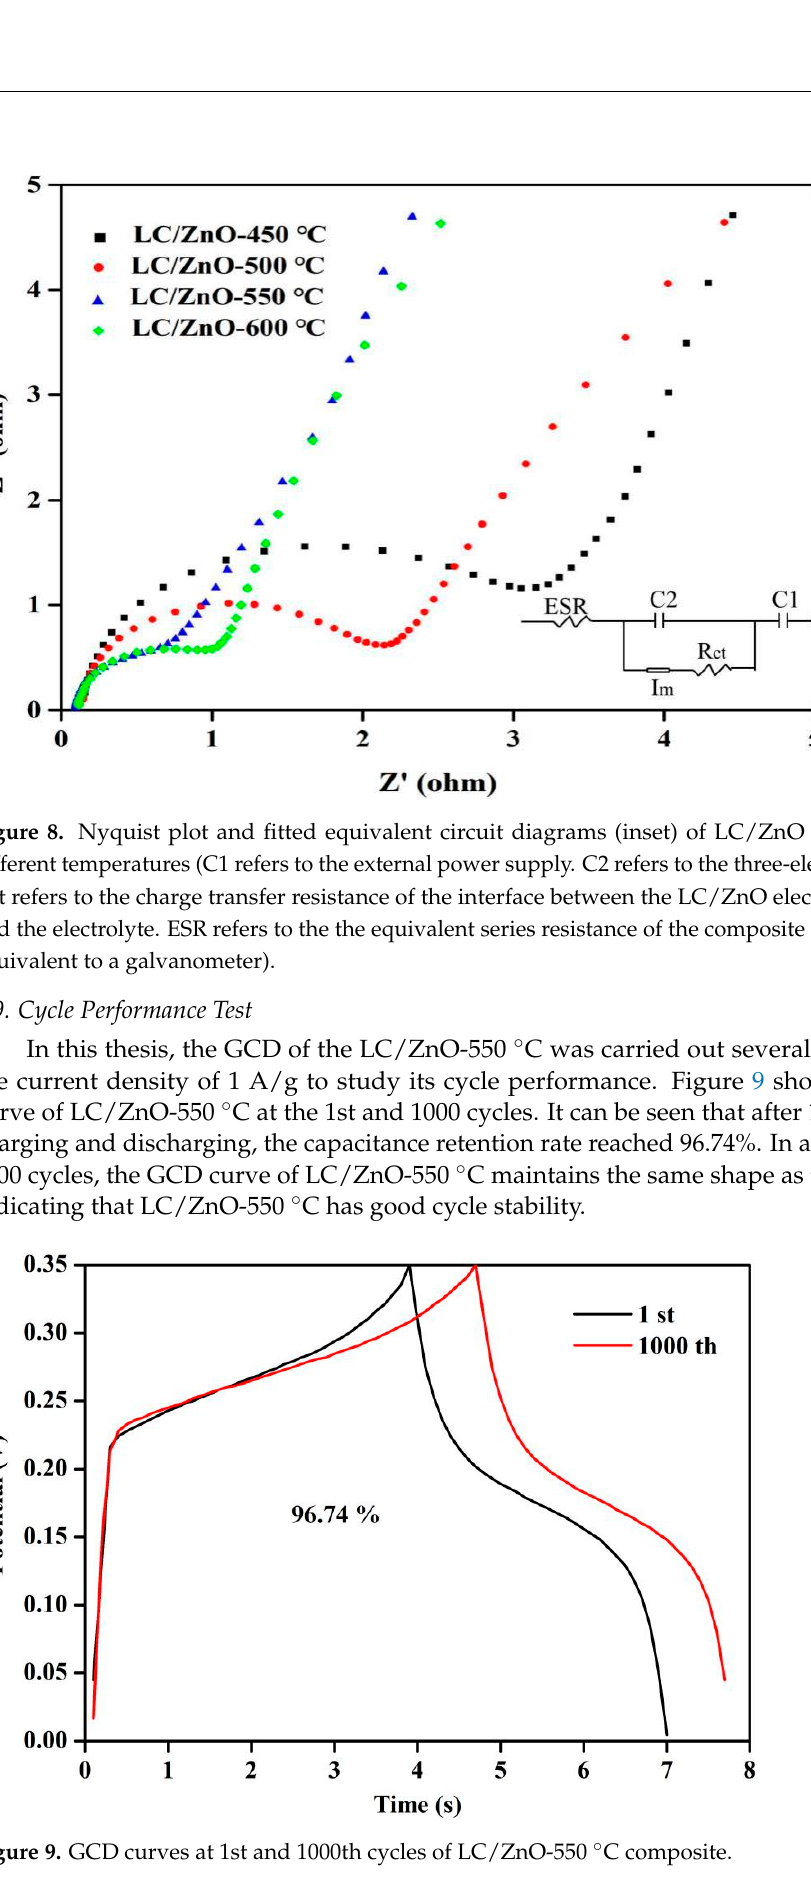
Figure 9. GCD curves at 1st and 1000th cycles of LC/ZnO-550 °C composite.